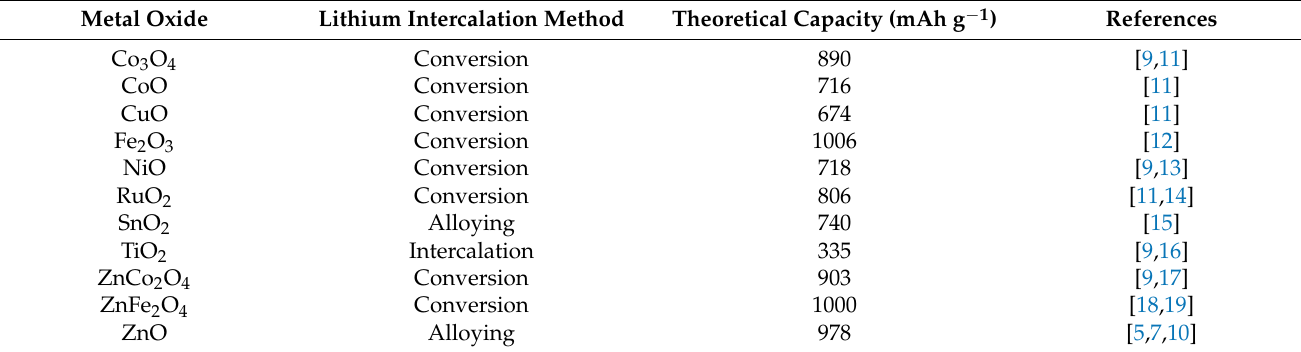
Table 1. Common MOs utilized as LIB anodes and their theoretical capacities. Metal